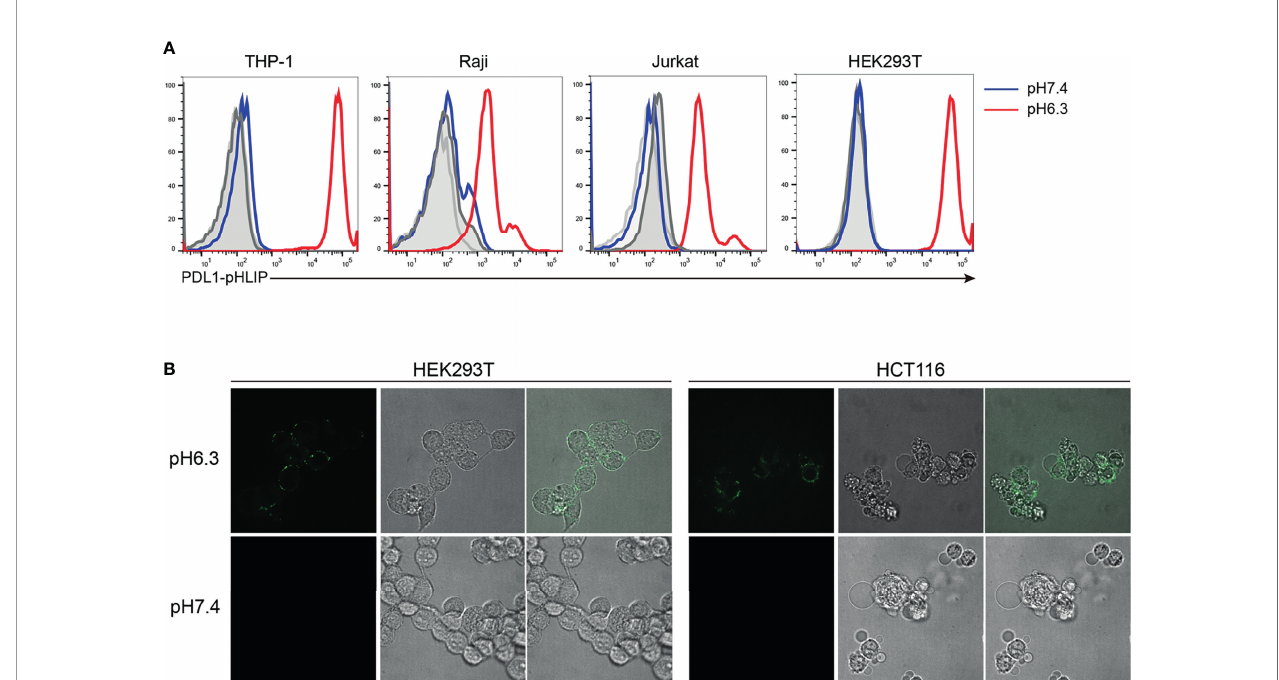
FIGURE 2 | The low pH-responding ability of PD-L1-pHLIP to insert into cell membrane. (A) PE-conjugated PD-L1-pHLIP (10 m g/ml) was incubated with different cell lines indicated in pH 7.4 or 6.3 buffer for 1 h, respectively. The insertion ability was examined by fl ow cytometry. (B) AF488-conjugated PD-L1-pHLIP (10 m g/ml) was incubated with HEK293T or HCT116 cell lines in pH 7.4 or 6.3 buffer for 1 h, respectively. The insertion ability was examined by microscopic imaging. Representative images from three independent experiments were